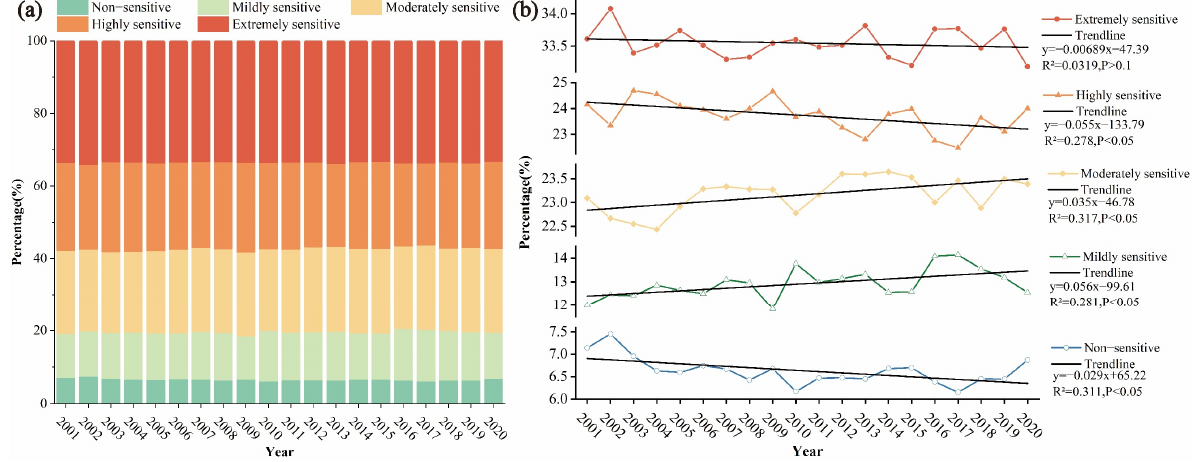
Figure 4. Proportion of image elements of each level of desertification sensitivity and sensitivity trends. ( a ) The percentages for each desertification sensitivity level from 2001 to 2020. ( b ) The evolution of the percentages of each desertification sensitivity level.